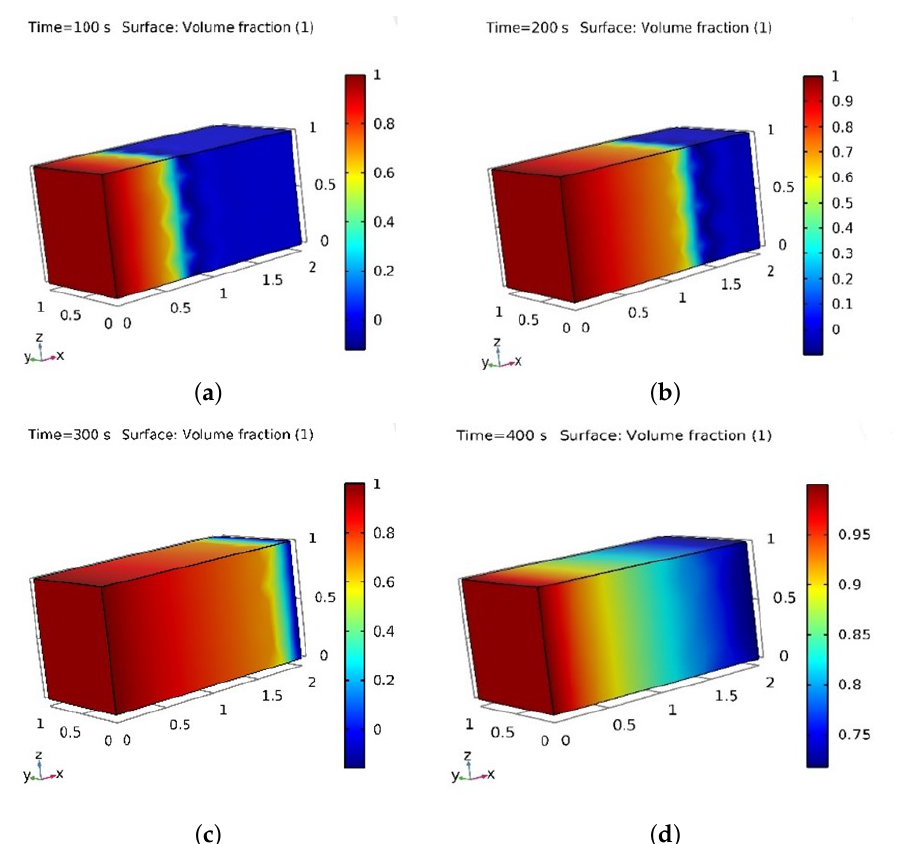
Figure 8. ( a ) Saturation of water at 100 s, ( b ) 200 s, ( c ) 300 s, and ( d ) 400